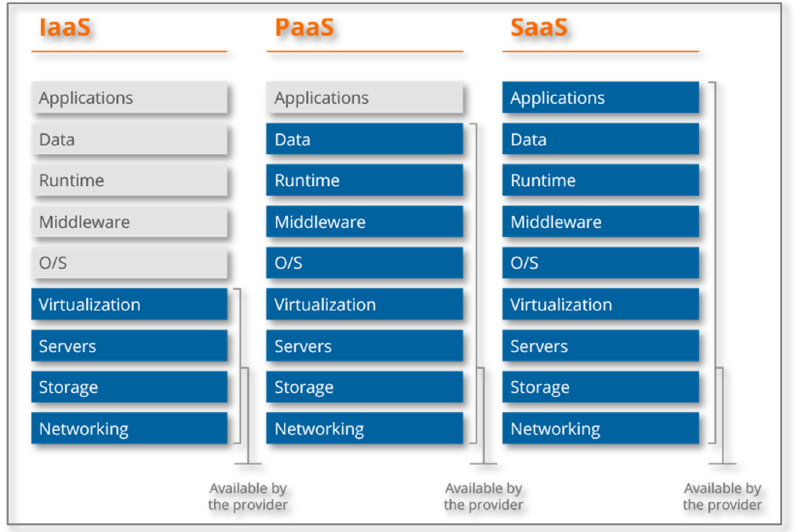
Figure 12. G-Cloud type of services in Greece. Reproduction from https://www.ktpae.gr/erga/gov- ernment-cloud-g-cloud/ (accessed on 08 May 2022).